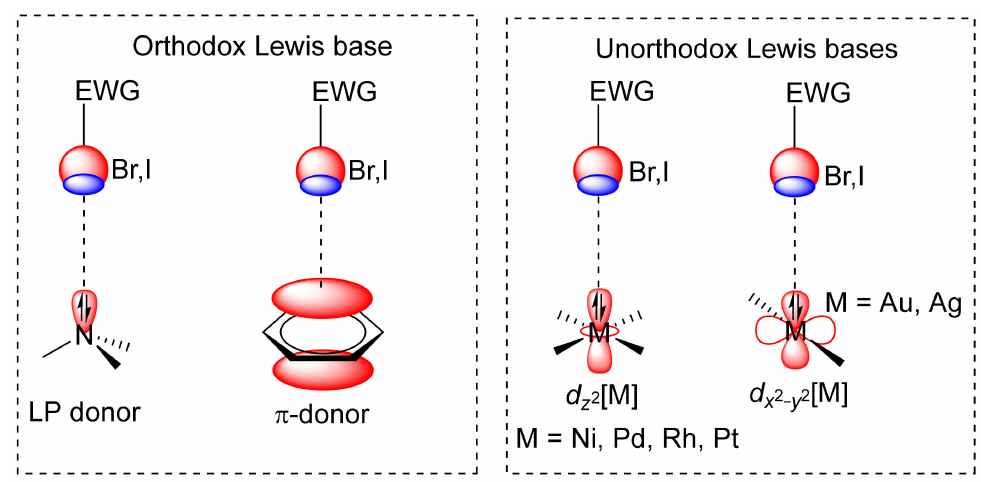
Figure 17. Schematic representation of orthodox (lone pair donors, π systems) and unorthodox Lewis bases (square planar and linear metal complexes) establishing a HaB.